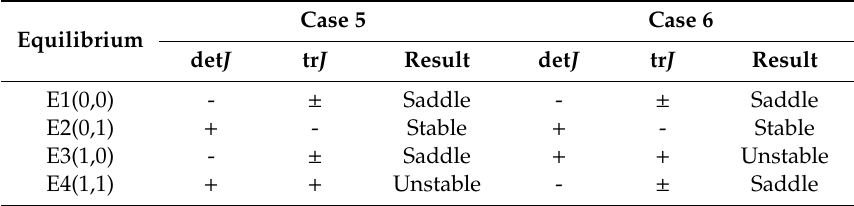
Table 7. Proposition 2: Analysis of local stability of equilibrium.